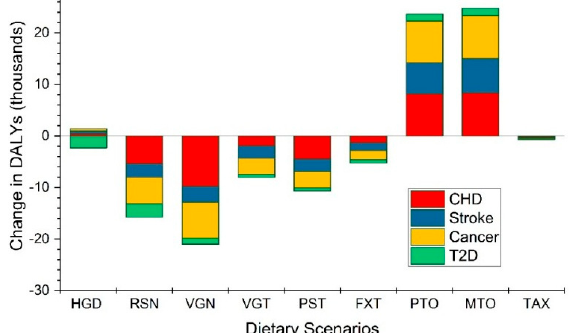
Figure 1. The human health consequences of shifting to an alternative diet. Negative numbers indicate human health benefit and positive numbers indicate an increase in adverse health outcomes. Four disease states used in the health impact model are ischemic or coronary heart disease (CHD), stroke, type 2 diabetes mellitus (T2D) and total cancer. Abbreviations: Healthy Global Diet (HGD), diet following the recommendation of Swiss Society in Nutrition (RSN), Vegan diet (VGN), lacto-ovo Vegetarian diet (VGT), lacto-ovo Pescatarian diet (PST), Flexitarian diet (FXT), protein-oriented diet (PTO), meat-oriented diet (MTO) and food greenhouse gas tax diet (TAX).